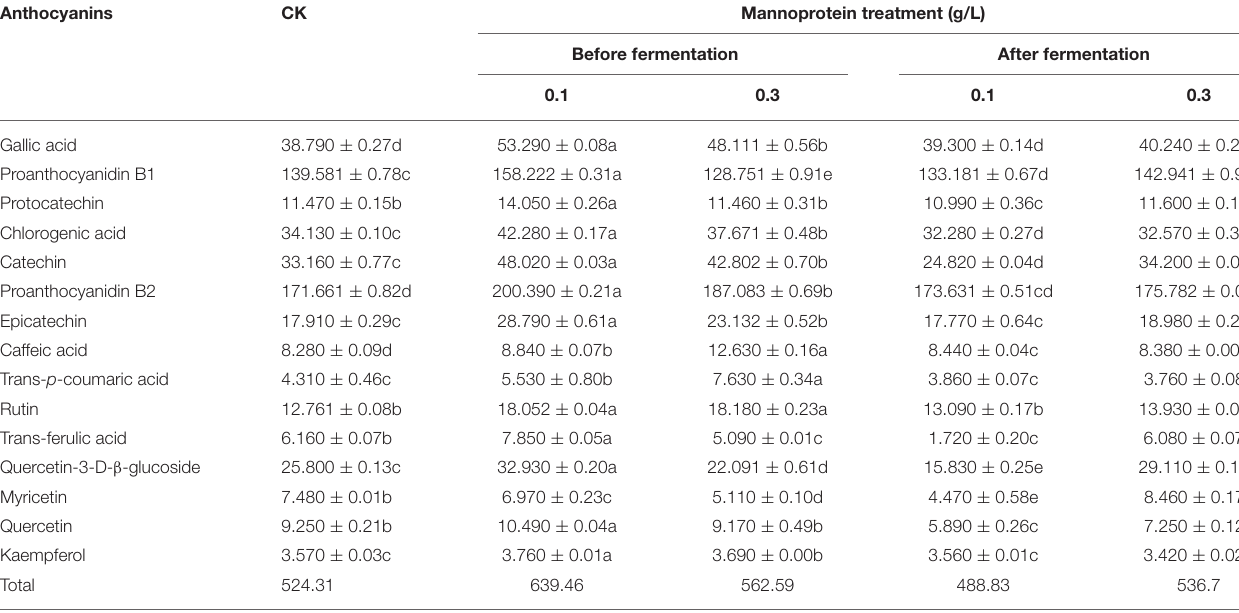
Different letters in the row indicate significant differences (Duncan test, p < 0.05) among treatments. CK, control group with 0 g/L MP.